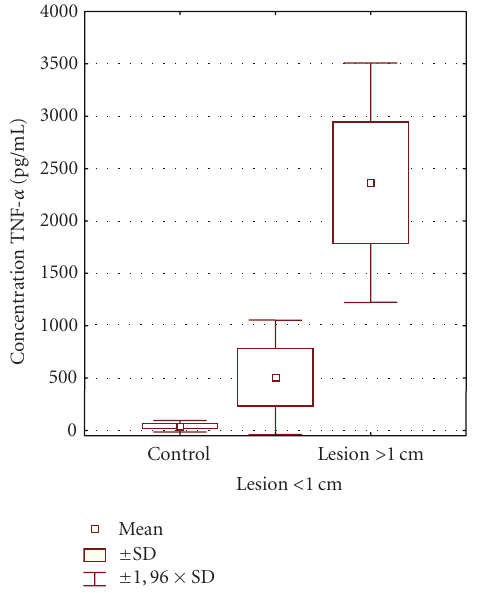
Figure 1: Levels of cytokine TNF- α in three groups of investigated